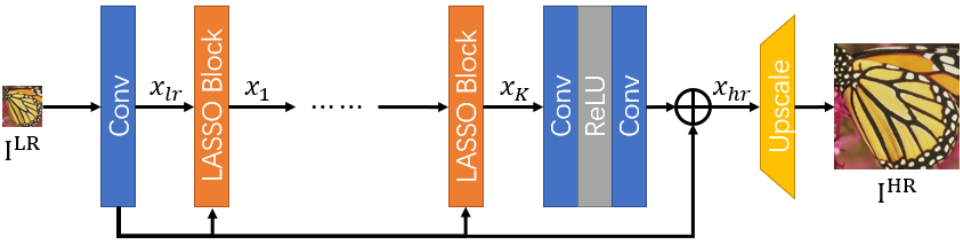
Figure 1. Network design of SCANet. x lr is the feature of the LR image, x i is the feature processed using i -th LASSO blocks, and x hr is the restored feature of the HR image.